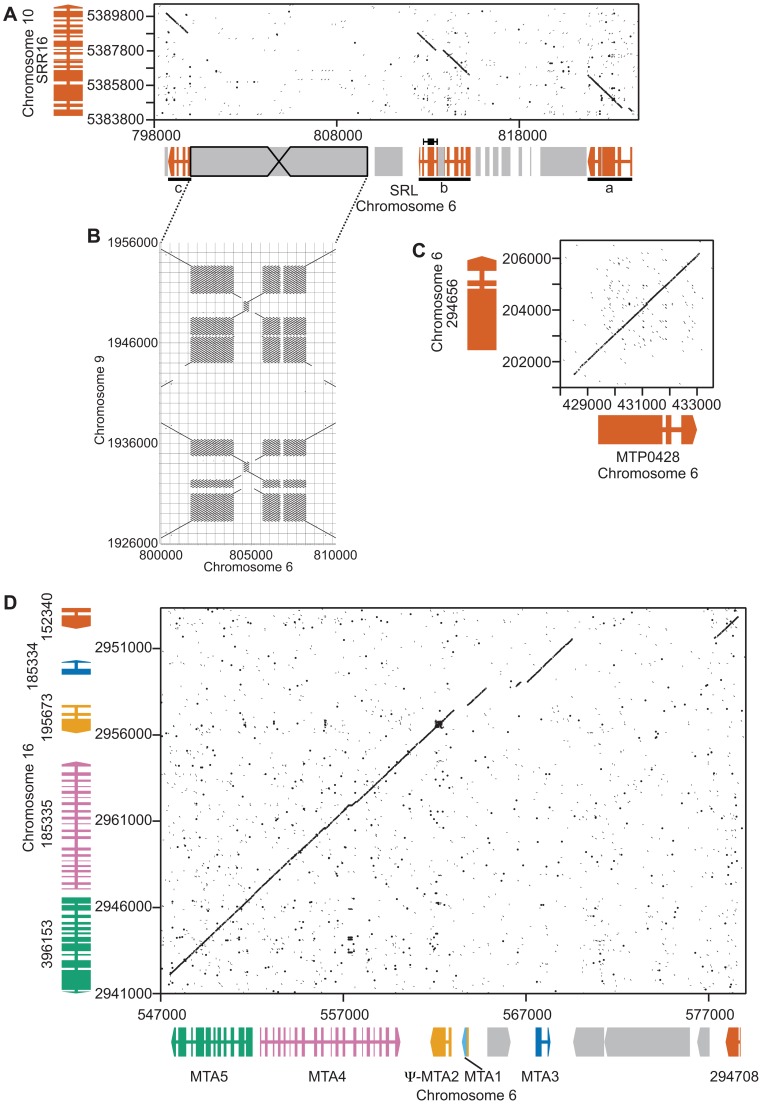
Structure of three MT+ regions derived from autosomal duplications.Dot plot comparisons of mating locus and autosomal regions. A. Autosomal gene SRR16 (y axis) and the SRL region (x axis). Wide and narrow colored rectangles depict exons and introns respectively for SRR16 and the SRL region that is broken into three underlined segments—a, b and c. Gray shaded regions represent repeats and transposons. B. Structure of a large inverted repeat within SRL that derives from chromosome 9. C. Autosomal gene 294656 (y axis) with MTP0428 (x axis). Gene structures are as described in Panel A. D. Autosomal a region (x axis) and MTA region (y axis). Individual genes are different colors with gene structures depicted as in Panel A.